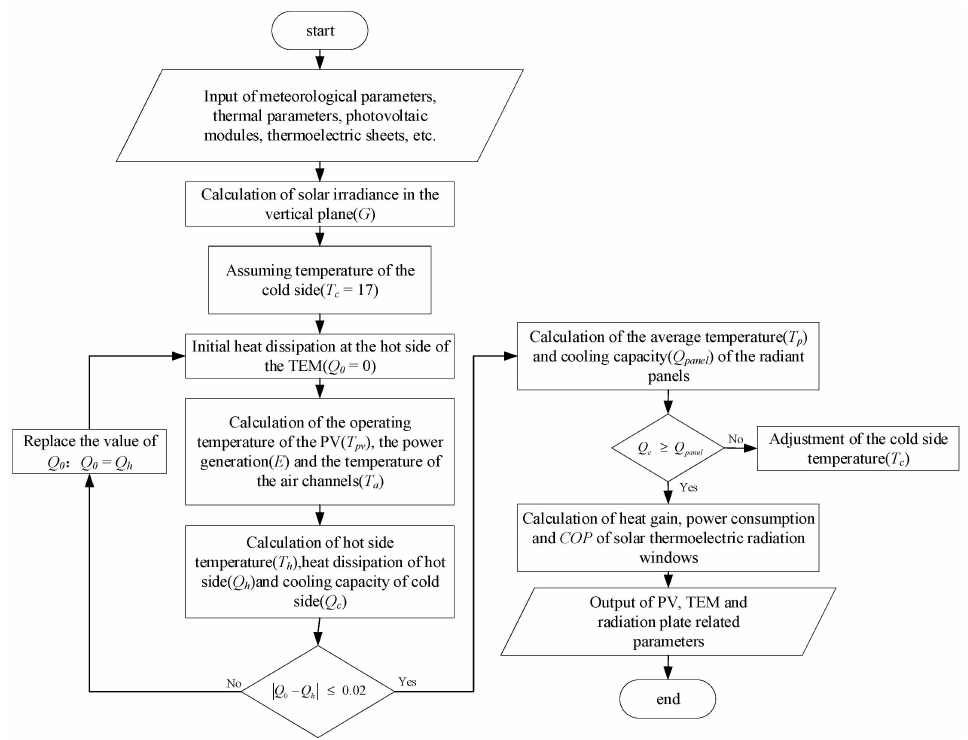
Figure 2. Flow chart of the numerical calculation of the PV-TEC radiant